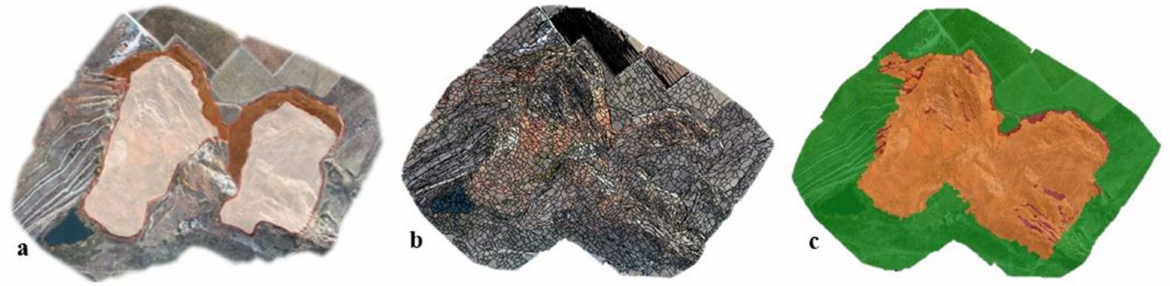
Figure 7. ( a ) Orthophoto overlaid by the reference data; ( b ) segmentation result; and ( c ) the final classification after refinement of the rule-based method for the RGB+DSM structure (green: non-affected, light brown: depletion, dark brown: